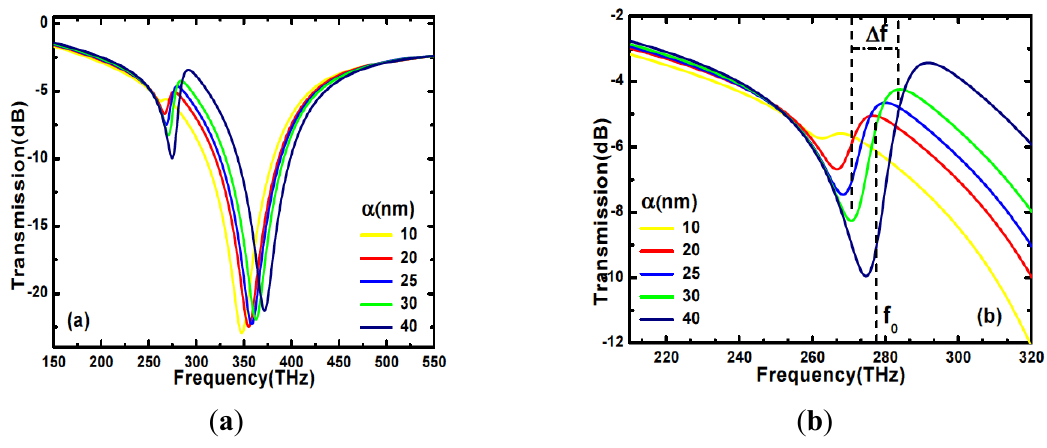
are shown for α = 30 nm. 0